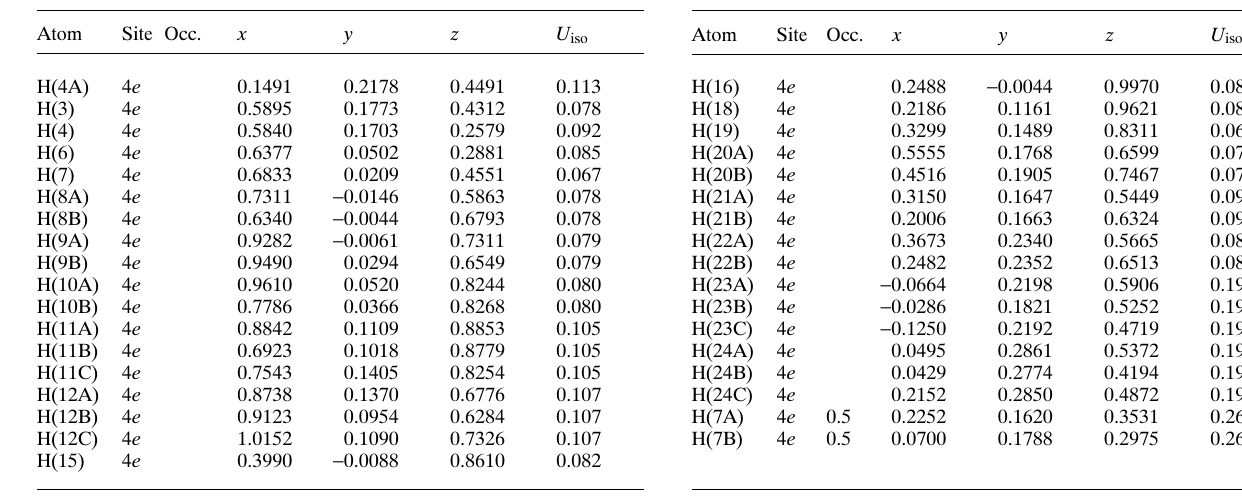
Table 2. Atomic coordinates and displacement parameters (in Å 2 )